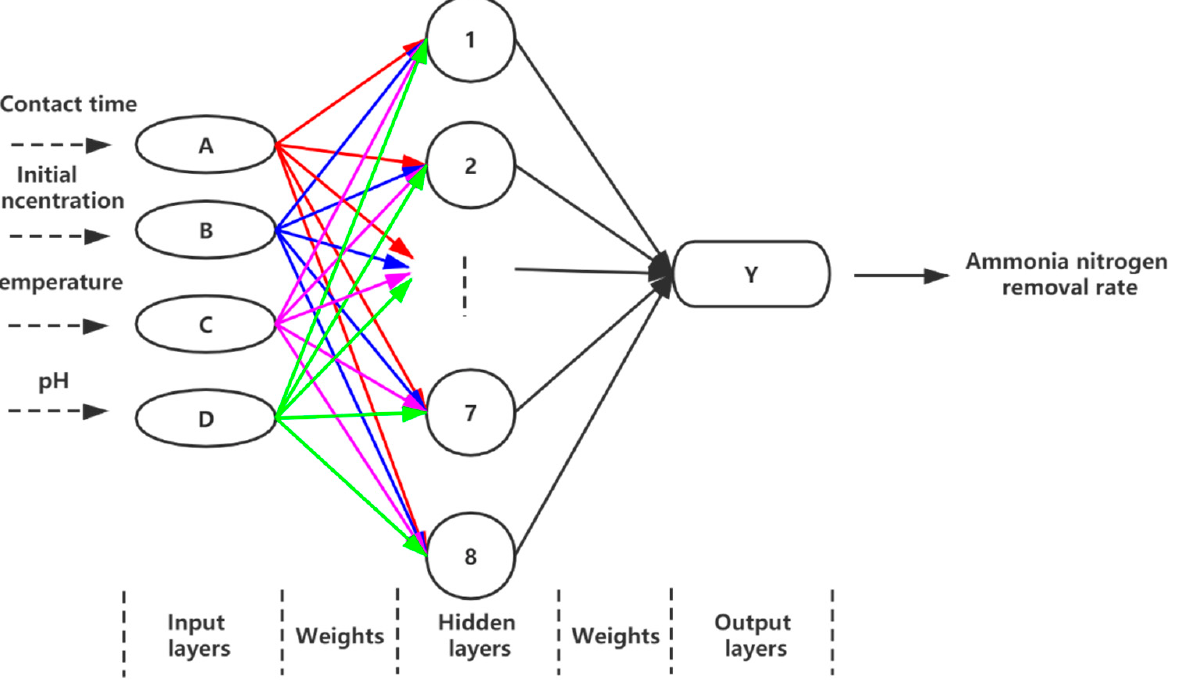
Figure 1. Simple illustration of the artificial neural network (ANN) structure. In this study, 29 experimental points were used to feed the neural network structure. These sites were divided into three training groups. It contains 16, 4, 4, 5 samples for training, testing, validation and simulation, respectively. Weights and deviations were updated with training data through Levenberge Marquardt algorithm, and the network generalization ability after training was evaluated with test data. In addition, the error of validation data was monitored during training to avoid overfitting [31]. The network used in this study consists of four input nodes (contact time, initial concentration, temperature, pH) in the first layer, and one output node in the third layer (NH 4 + removal rate). Normalization can accelerate the convergence of the training network and reduce the impact of different orders of magnitude of the input data set. For increasing the training rate of the network [19], all the input and output variables were normalized to 0–1